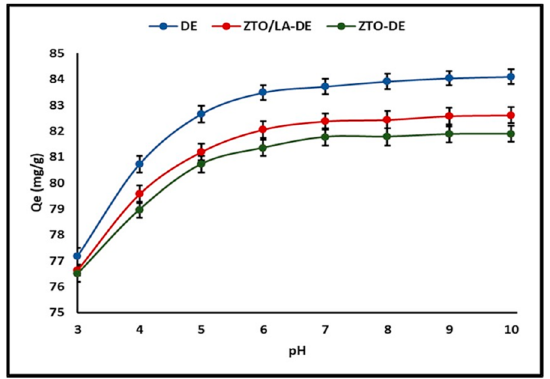
Figure 6. Effect of pH on MB adsorption onto composites.